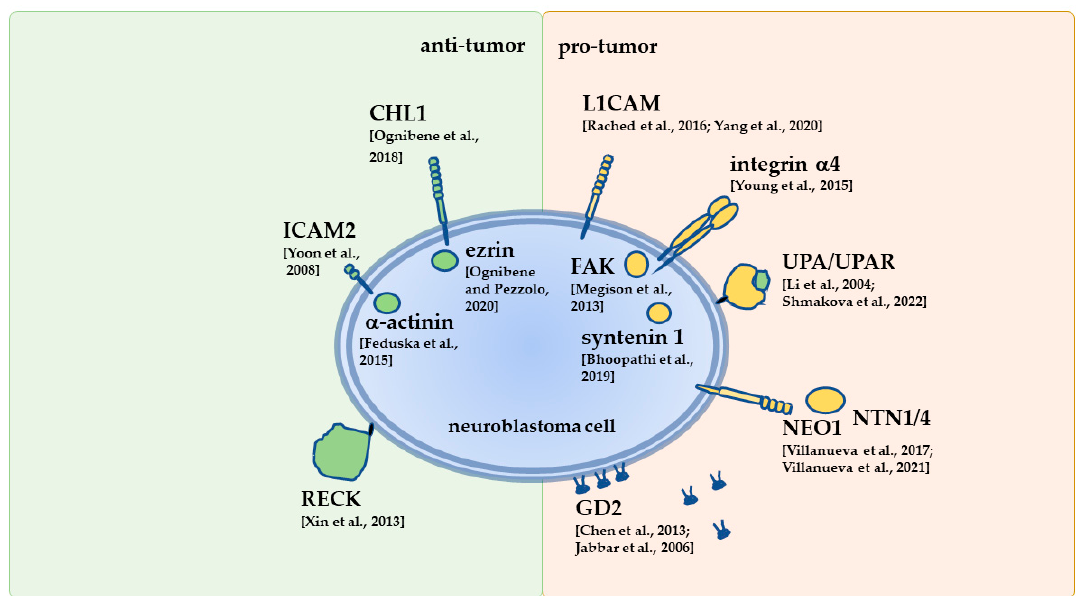
Figure 2. Examples of factors mediating interactions of NB cells with the ECM that affect malignancy (see Sections 4–6 for more detail)